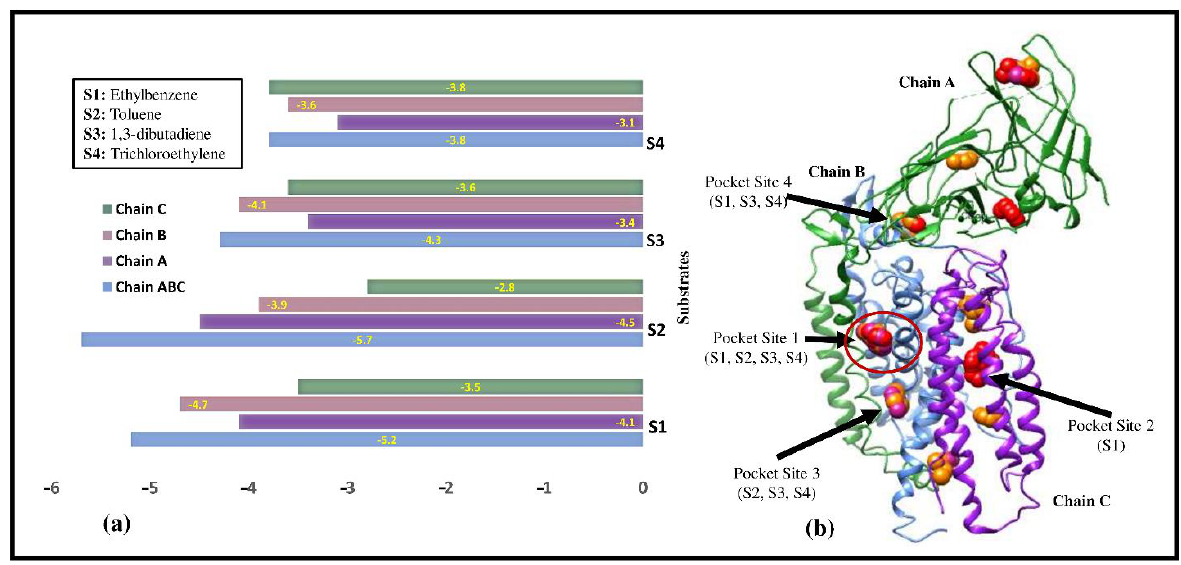
Figure 3. ( a ) Plot of binding energies between substrates and Chain A, Chain B, Chain C, and modeled pMMO monomer. ( b ) The surface interactions between the substrates and modeled pMMO. Chain A is shown in the light sea green color, Chain B is shown in purple, and Chain C is shown in light blue. The substrates are shown as red spheres.